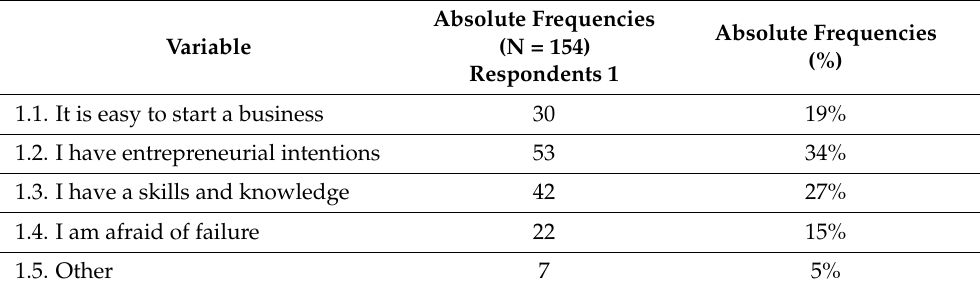
Table 5. What are the motivations and aspirations for entrepreneurship during high school (Question 2).